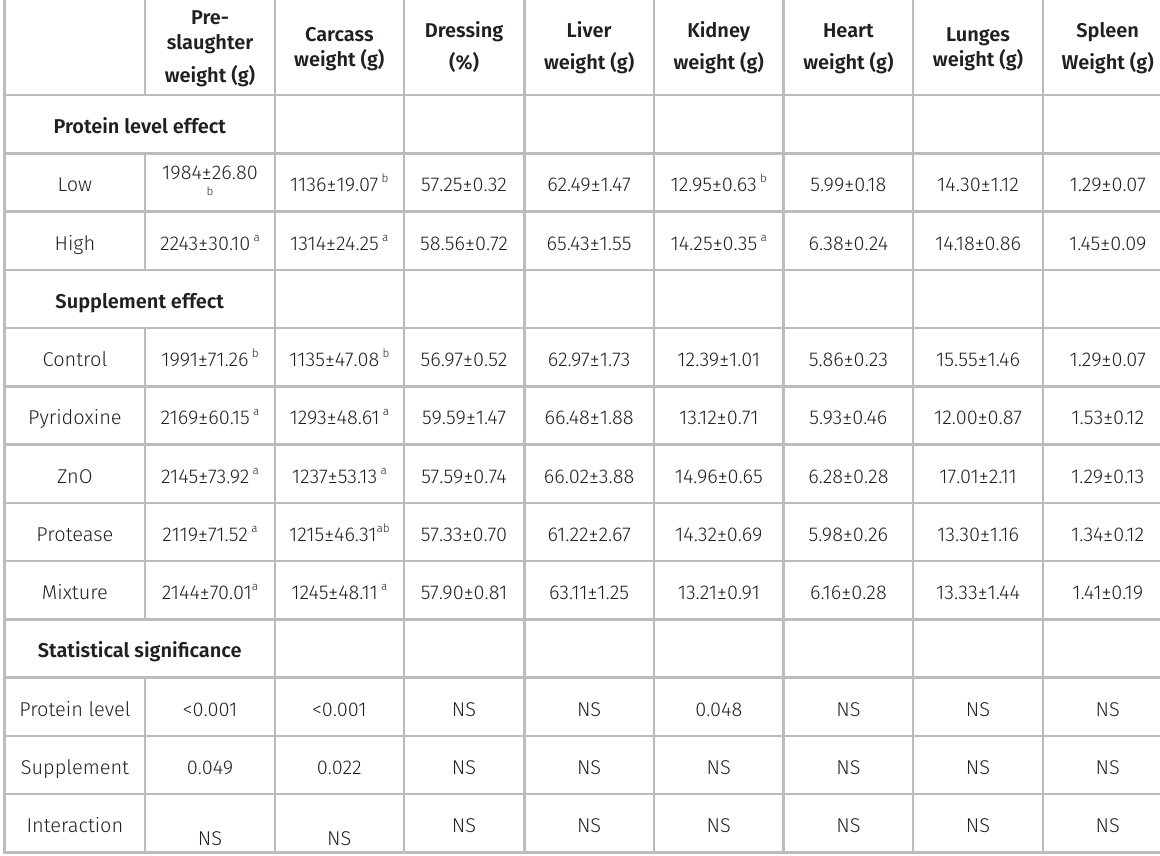
Table VII. Carcass and some internal organs weights (g; mean± SE) of growing New Zealand White rabbits as affected by protein level and tested feed